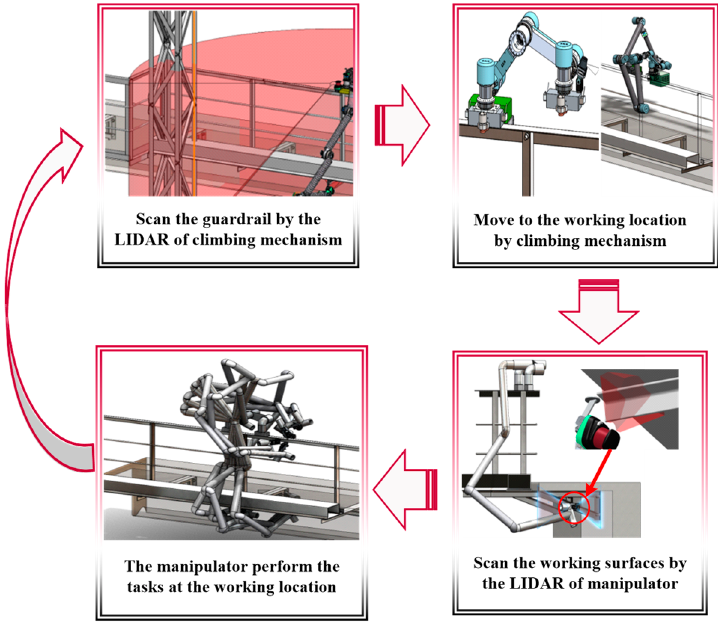
Figure 7. Schematic diagram of the main work procedures of the CMBOT.